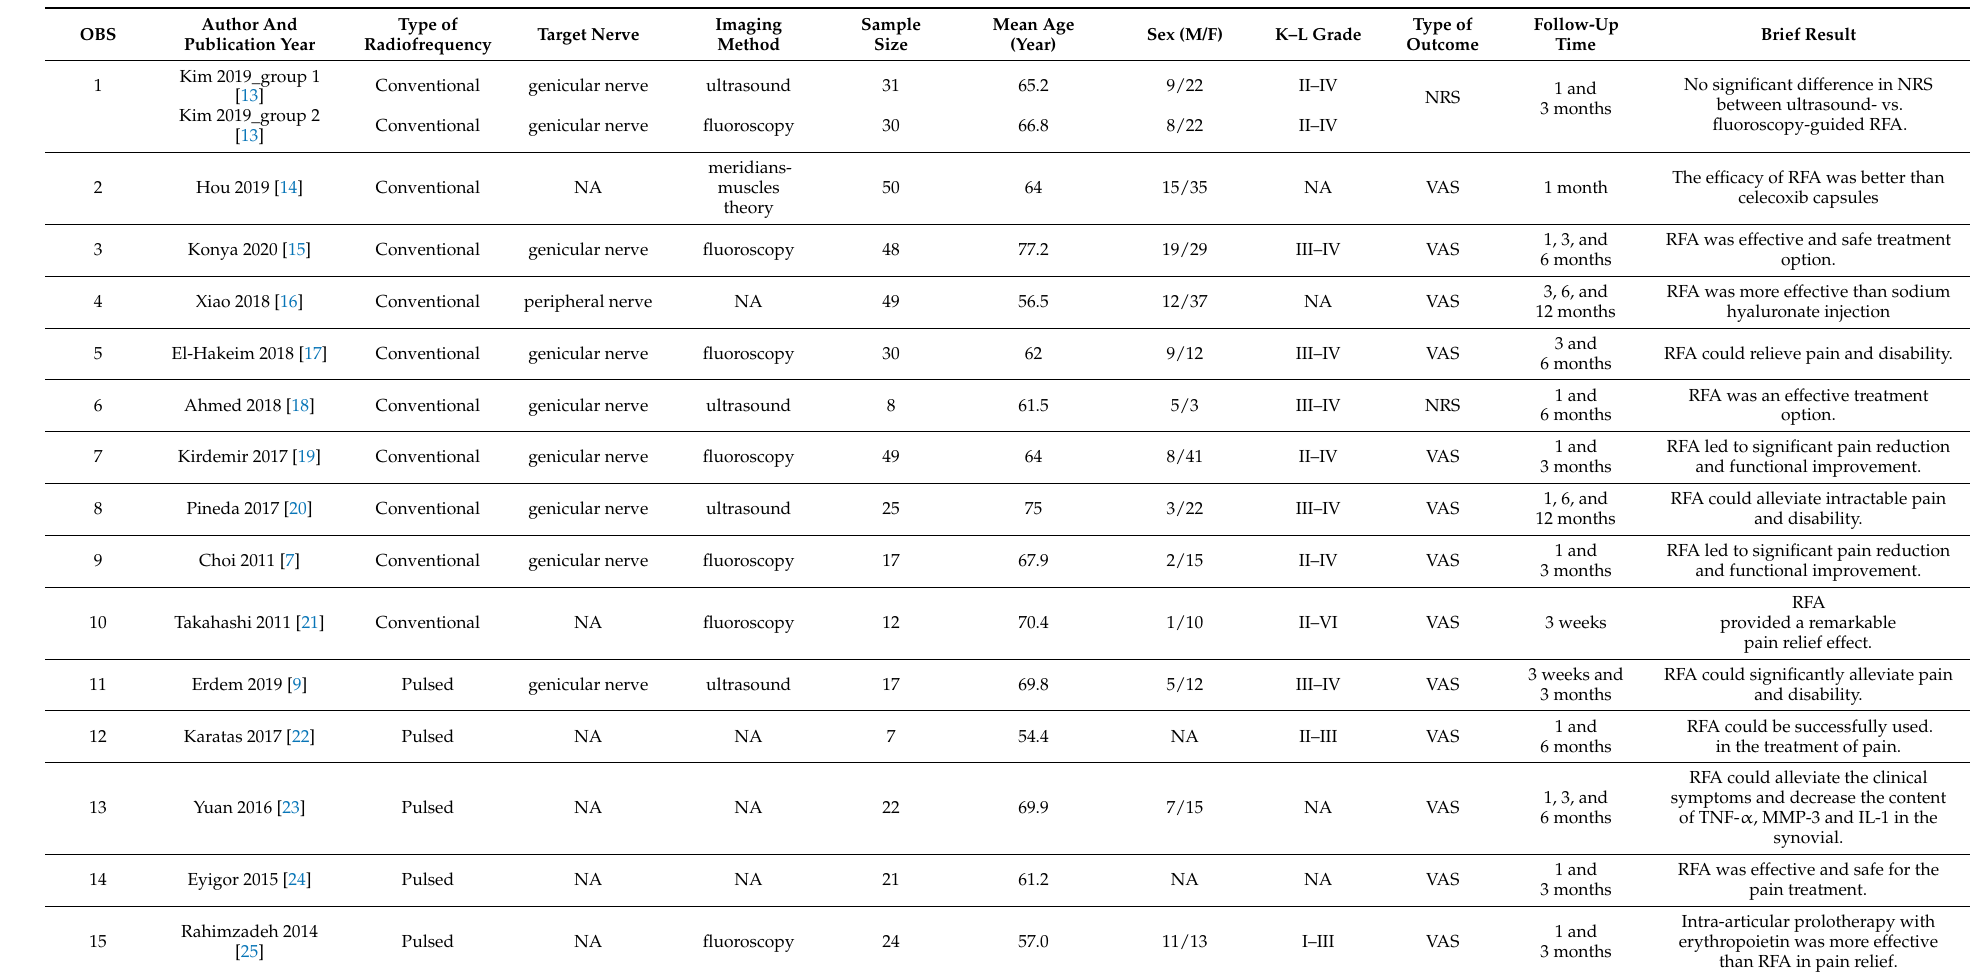
Table 1. Main characteristics of the articles included in this